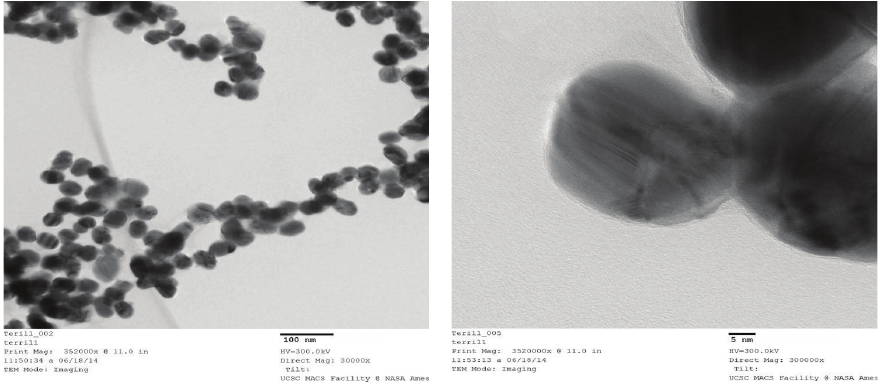
Figure 2: Transmission electron microscopy (TEM) images of the Au@Ag